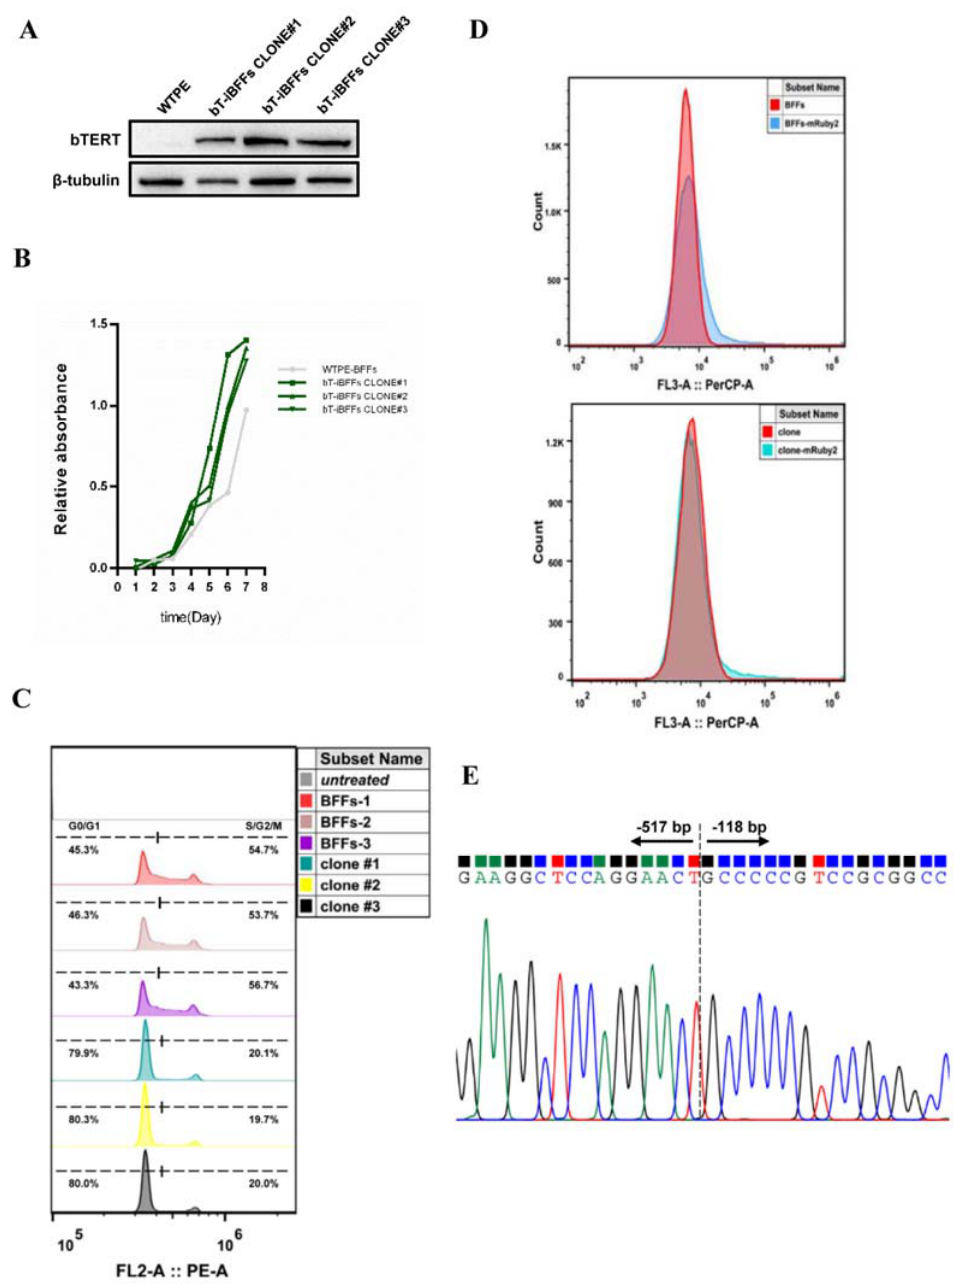
Figure 3. Characteristics of bT ₋ iBFFs by HMEJ ₋ based CRISPR/Cas9 ₋ mediated b TERT insertion at the b ROSA26 locus. ( A ) Protein expression of bTERT in bT ₋ iBFF colonies detected by Western blot. “WTPE” represents wild ₋ type. Bovine β ₋ tubulin served as internal reference. ( B ) Cell proliferation abilities of 1st passage of wild ‐ type BFFs and 80th passage of bT ₋ iBFFs clones by CCK8 cell proliferation assay. ( C ) Cell cycle comparison between 1st passage of primary BFFs and 80th passage of bT ₋ iBFF colonies. ( D ) Comparison of the gene manipulation efficiency of the primary BFFs and bT ₋ iBFFs by FACS. Non ₋ transfected cells were used for negative control. ( E ) Sanger sequencing results of target sites of the b TERT promoter region in bT ₋ iBFFs after the predicted p53 and WT1 binding sites were knocked out.